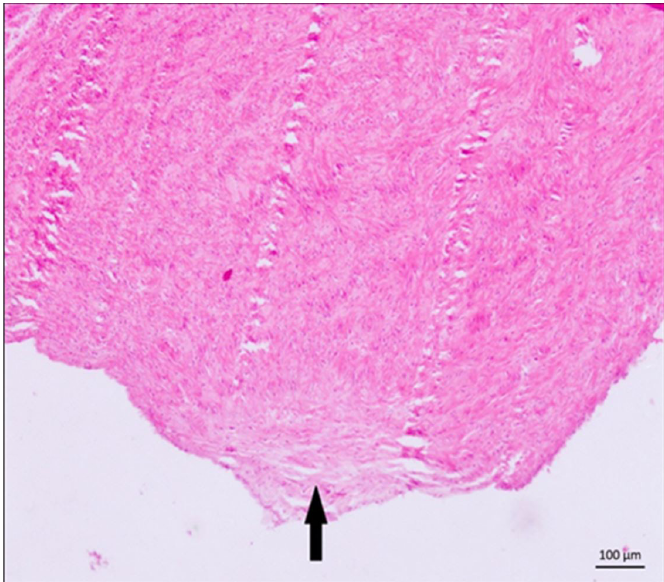
Figure 3. Histological section of the left atrioventricular valve showing collagen deposition (arrowhead). (H&E,